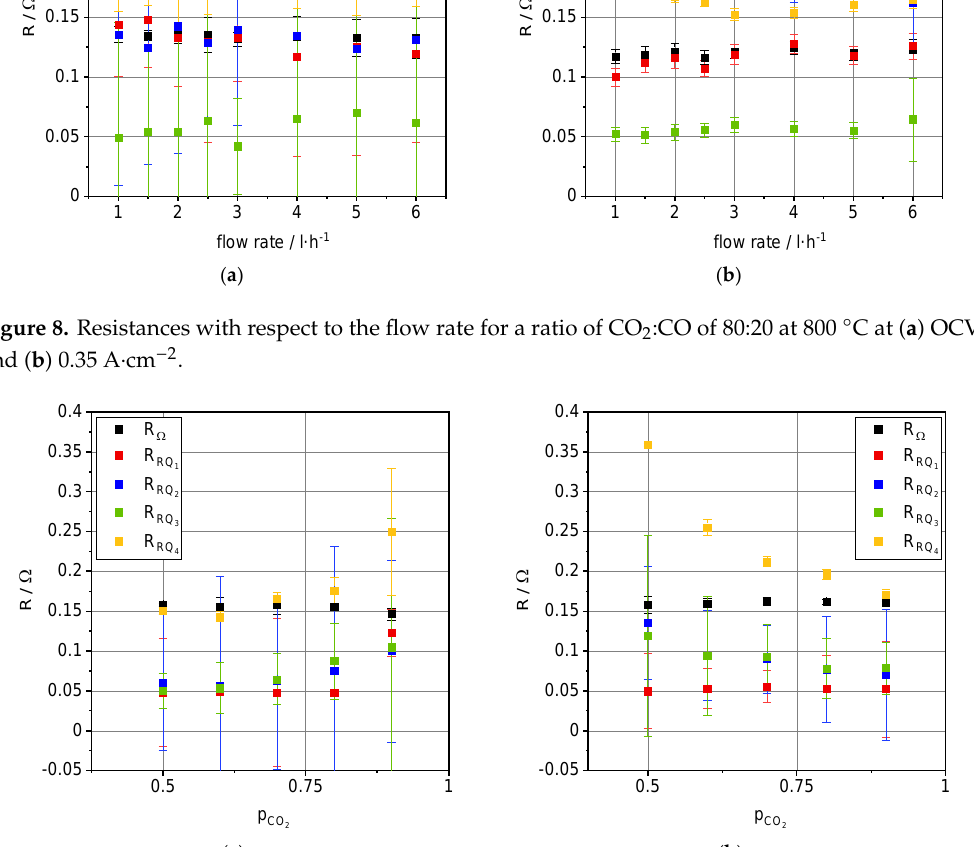
Figure 8. Resistances with respect to the flow rate for a ratio of CO 2 :CO of 80:20 at 800 °C at ( a ) OCV and ( b ) 0.35 A·cm −2 .